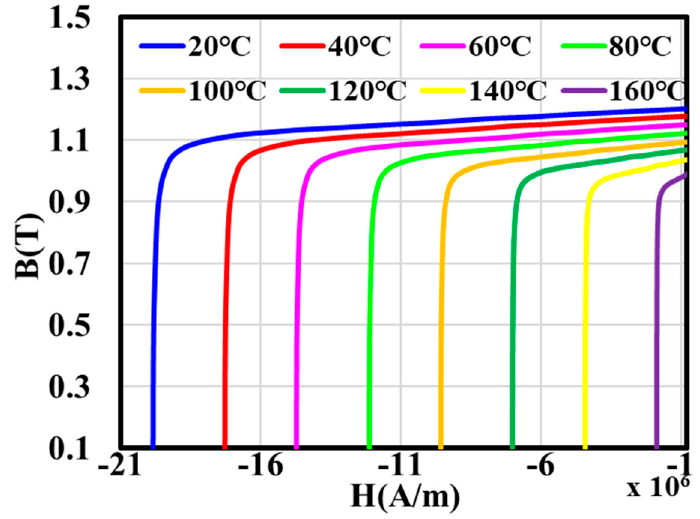
Figure 3. Demagnetization B − H curve at different temperatures.